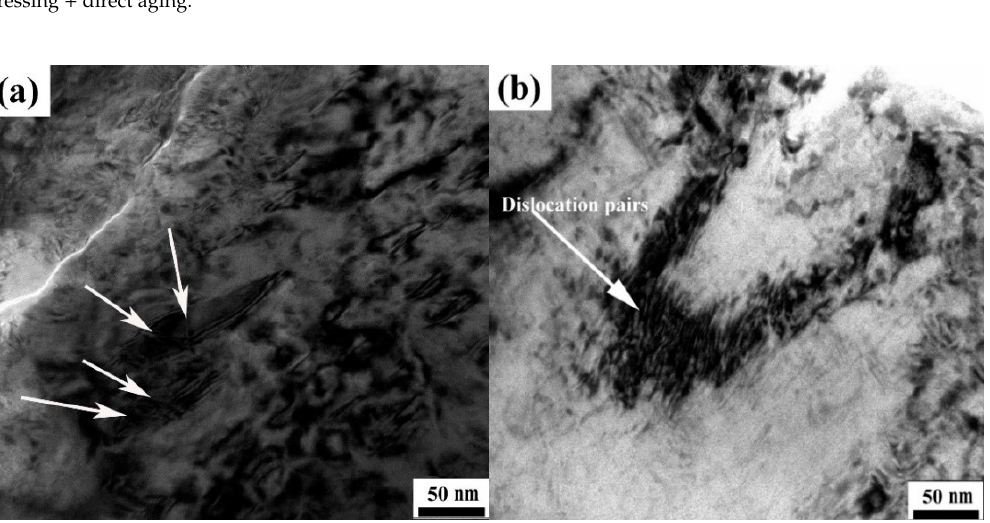
Figure 9. TEM micrographs of the deformed region of the tensile specimen after HIP + DA treatment: ( a ) relatively coarser γ ” precipitates and ( b ) dislocation pairs.